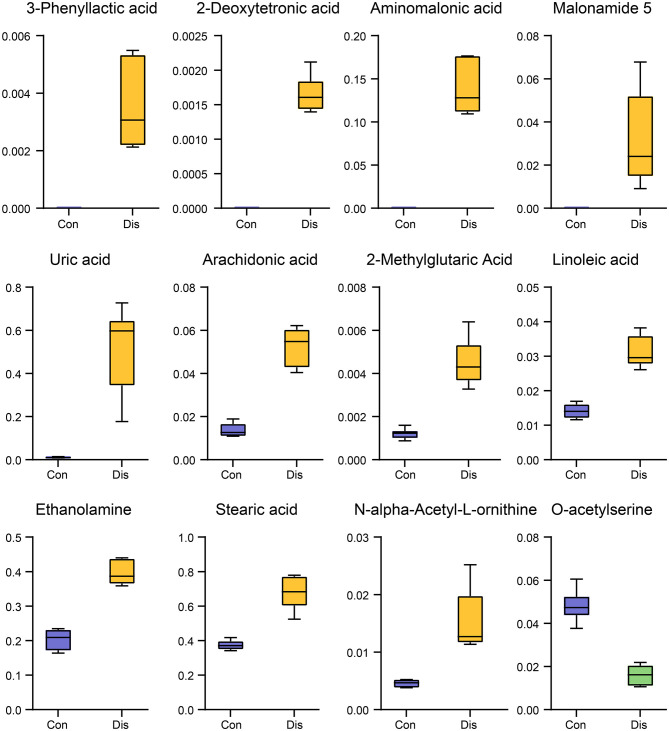
Box–whisker plots of the 12 potential biomarkers in the Dis and Con groups.